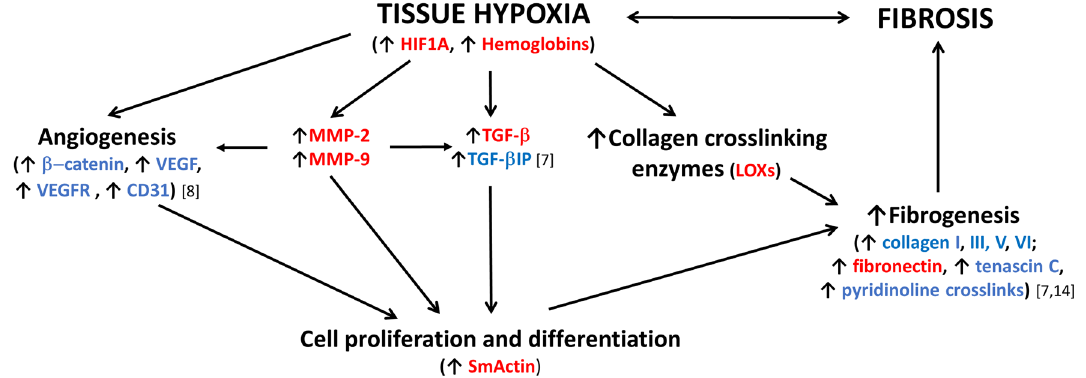
Figure 4. Diagram of protein interactions involved in fibrosis formation in (relapsed) clubfoot. Marked proteins were found significantly upregulated (red—in this study; blue—in this study and/or in our other studies 7,8,14 . SmActin alpha smooth muscle actin, HIF1A hypoxia-inducible factor 1 alpha, MMP-2, MMP-9 matrix metalloproteinase-2 and 9, LOXs lysyl oxidases, TGF-β transforming growth factor-beta, TGF-βIP transforming growth factor-beta-induced protein, VEGF vascular endothelial growth factor, VEGFR vascular endothelial growth factor